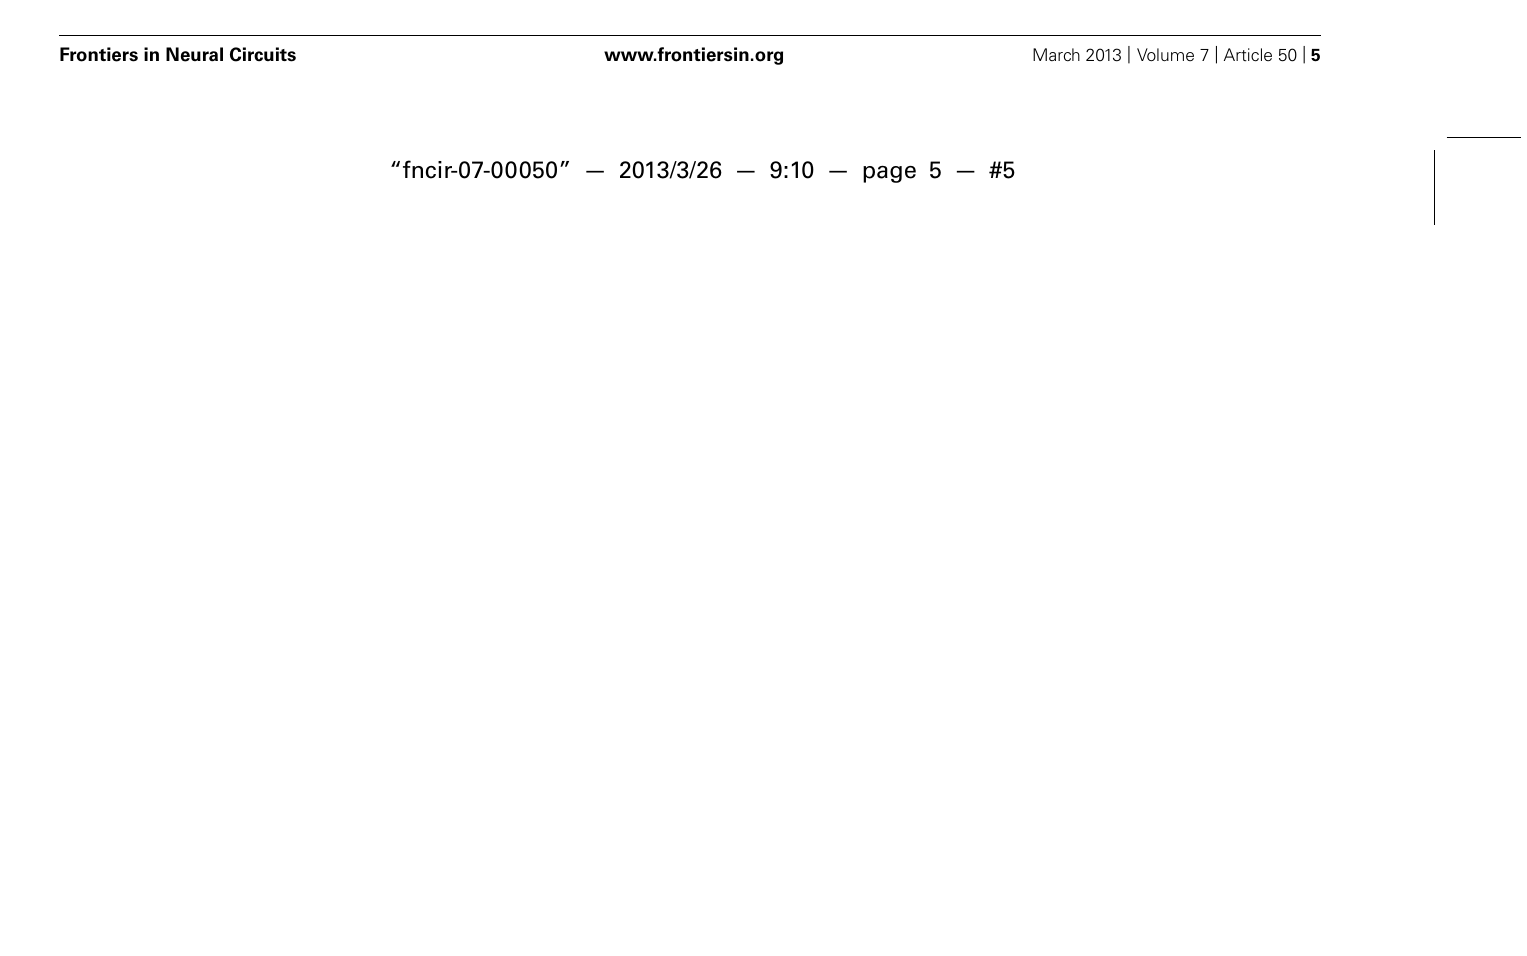
deviation of the image velocities (C) Normalizing the image velocities in (B) by their corresponding standard deviations results in response functions with similar slopes (around σ v = 0 deg/s).The respective peak spike rates (normalized), however, remain